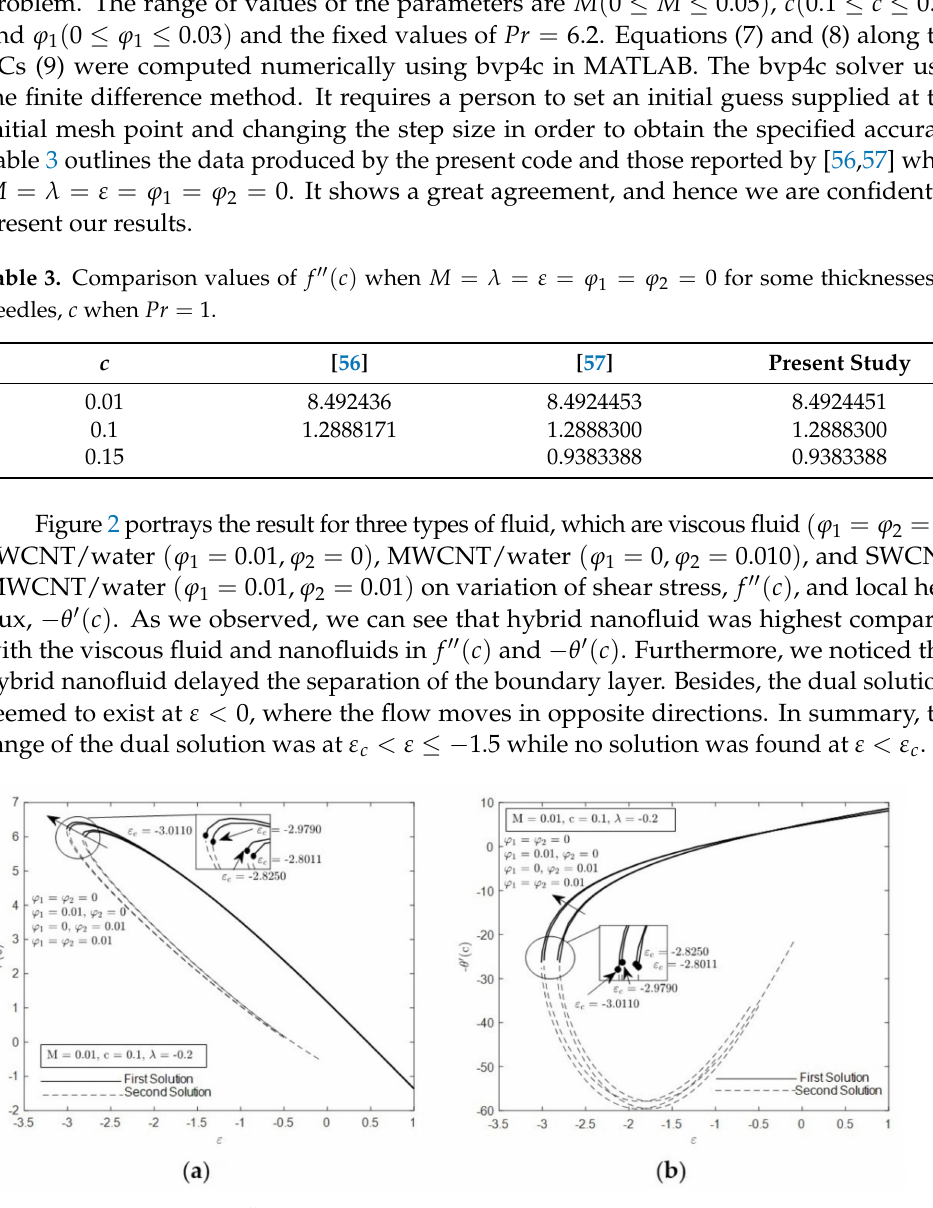
Figure 2. ( a ) Variation of f (cid:48)(cid:48) ( c ) with velocity parameter, ε for types of fluid. ( b ) Variation of with velocity parameter, ε for types of